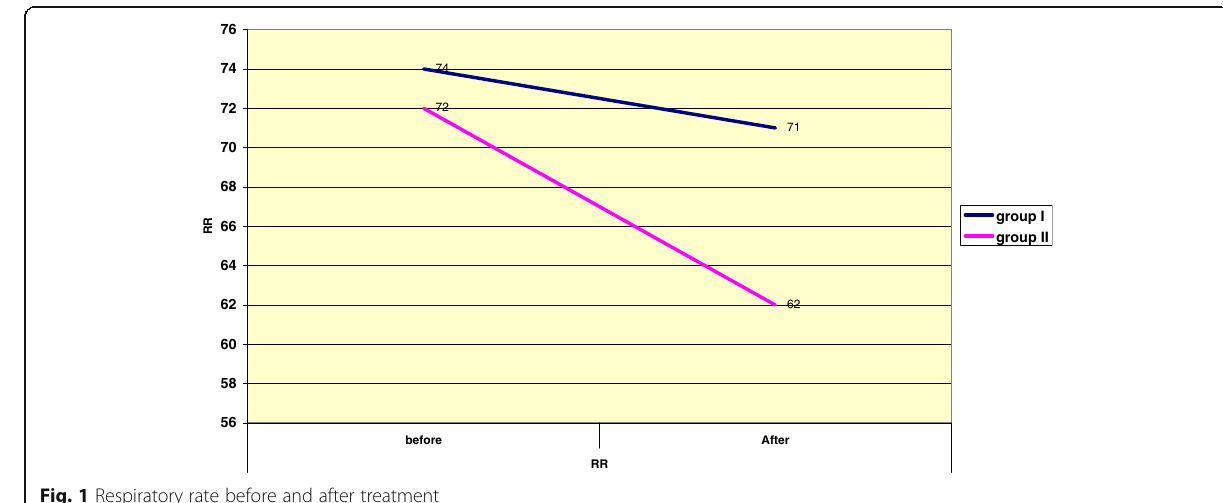
Fig. 1 Respiratory rate before and after